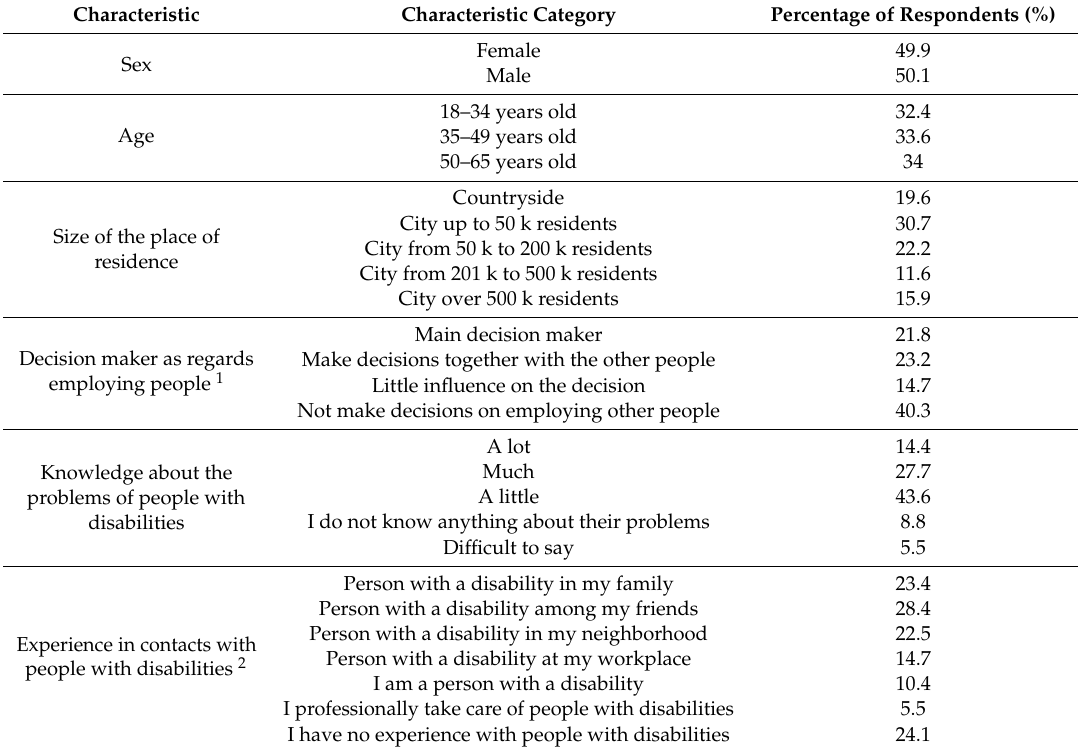
Research sample—structured according to selected demographic and professional characteristics and knowledge of disability issues ( N =